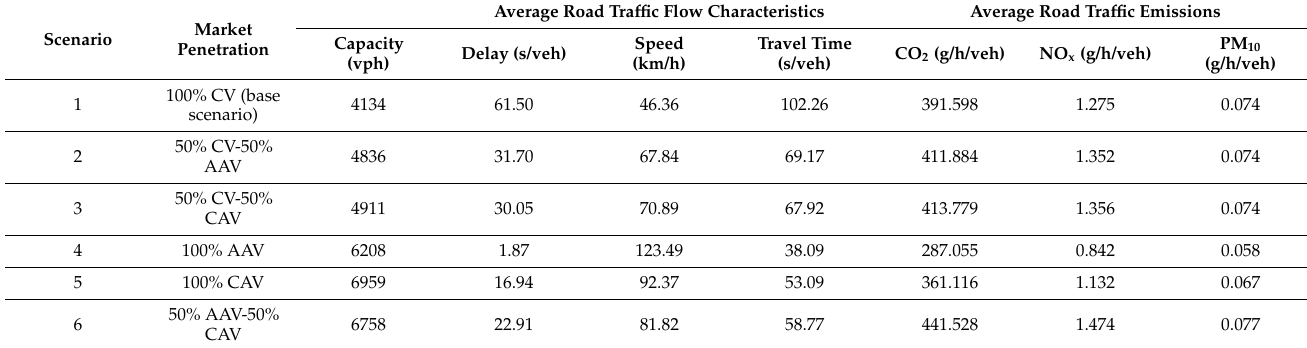
Table 3. Traffic flow characteristics and traffic emissions for merging segment.